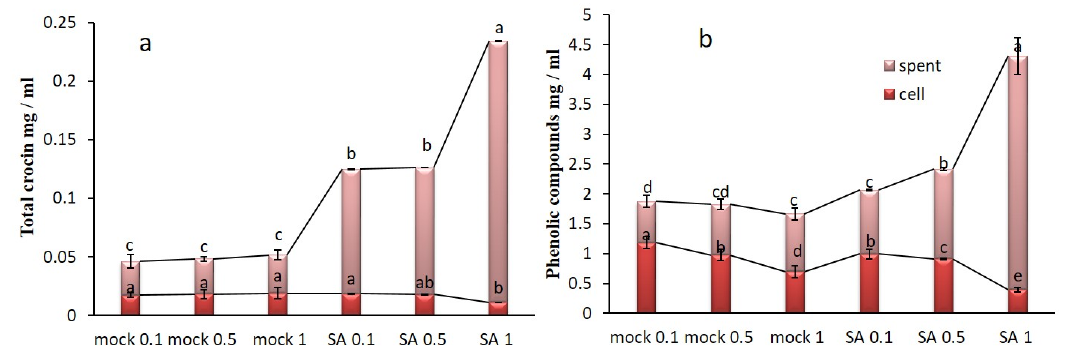
ff ron cell suspension